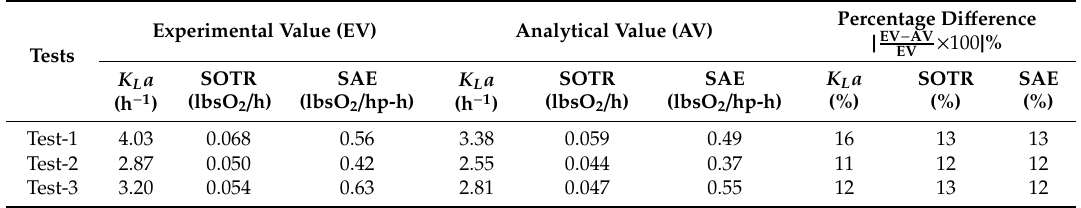
Table 3. Performance of aeration experiments.